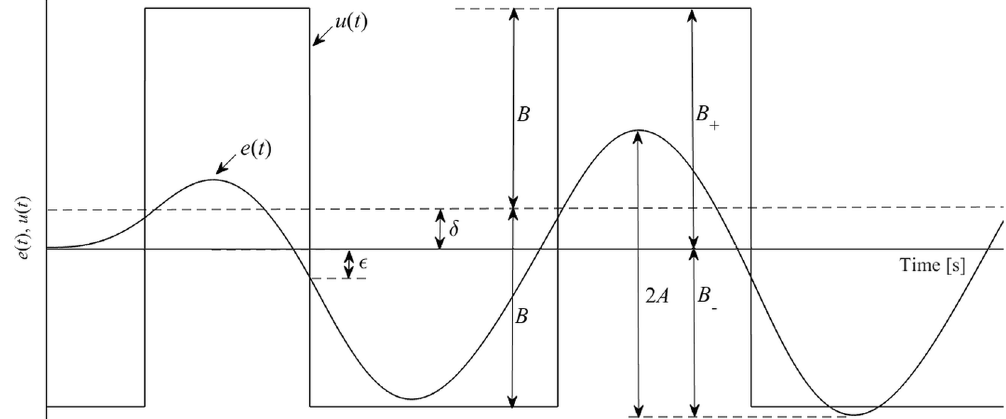
Figure 3. Sustained oscillations using the asymmetrical biased relay.